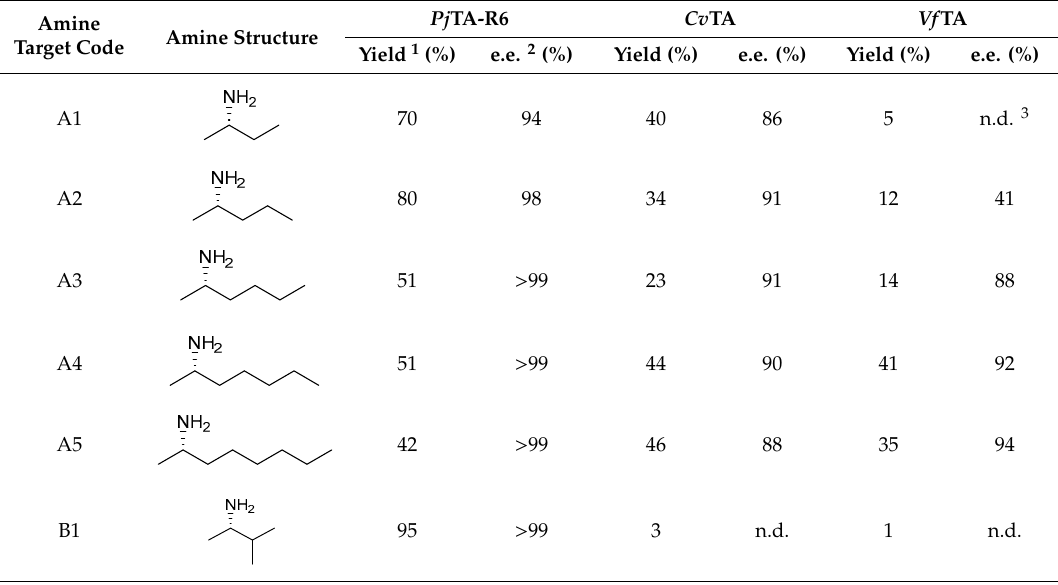
Table 1. Analytical yields and enantiomeric excesses for the production of A1–A5 , B1–B3 , and C1–C2 using a six-fold mutant of transaminase from Pseudomonas jessenii ( Pj TA-R6), a transaminase from